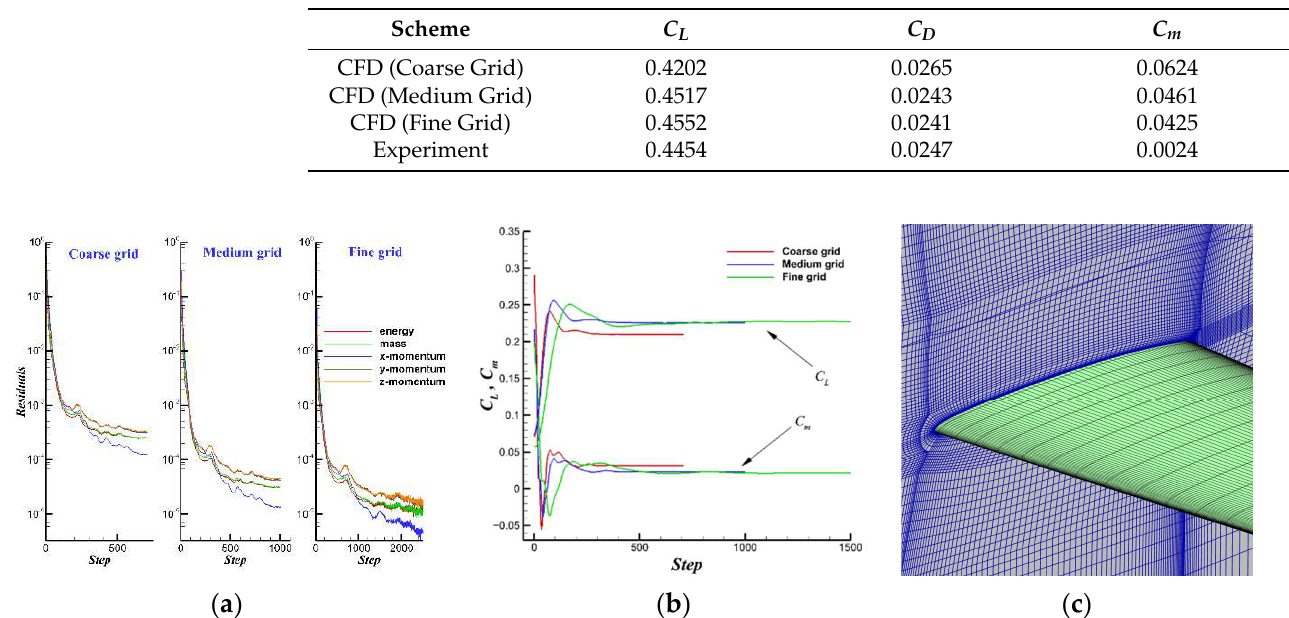
Table 2. Influence of grid size on aerodynamic characteristics.